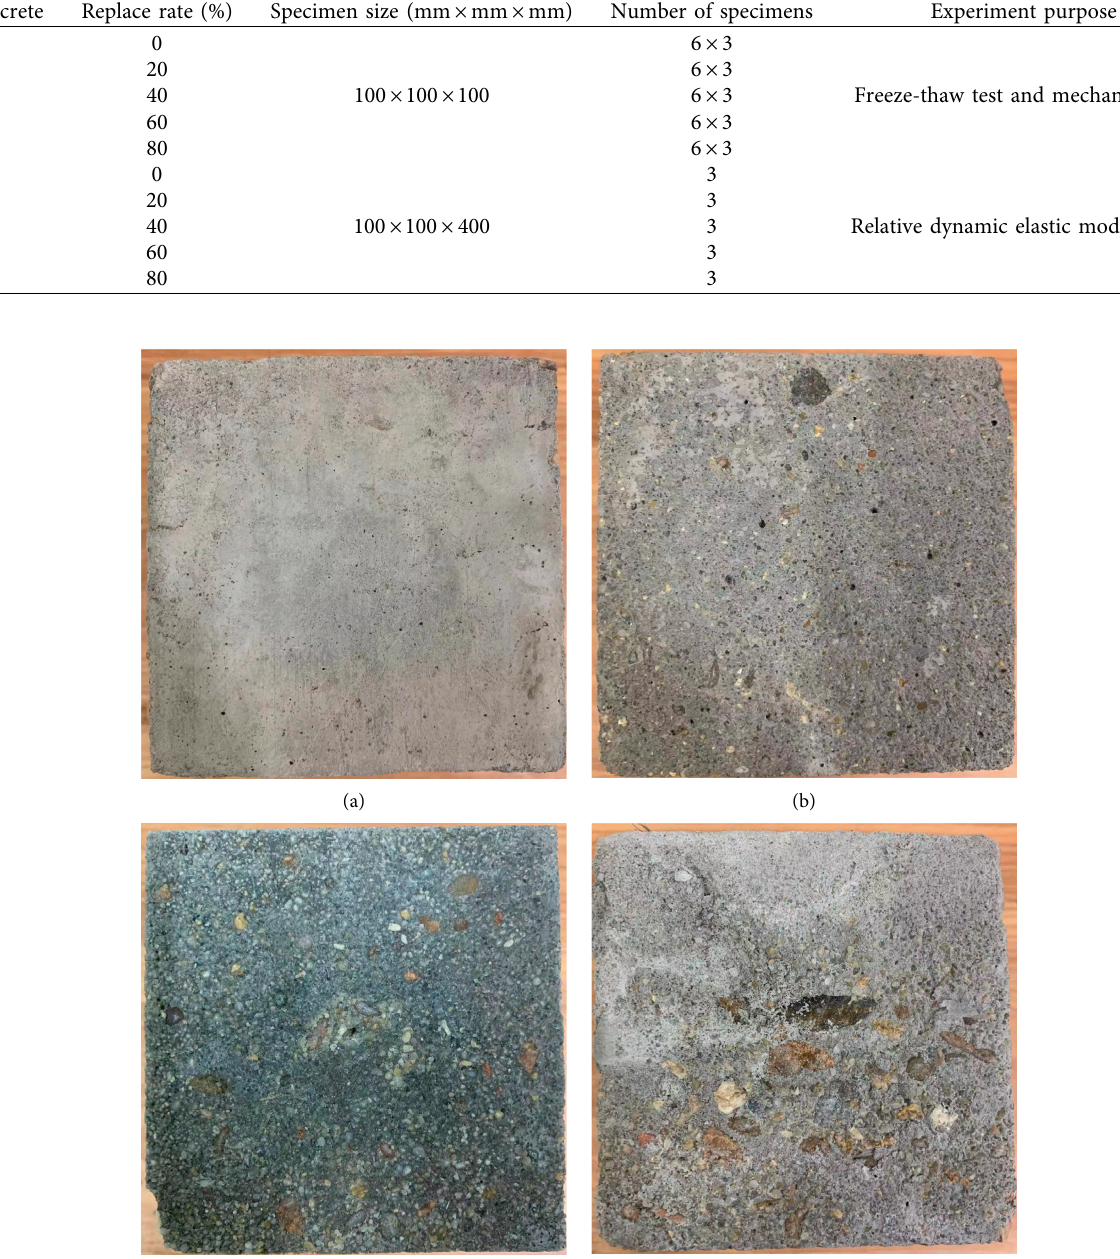
Table 4: The experimental plan and sample quantity of iron tailing concrete.